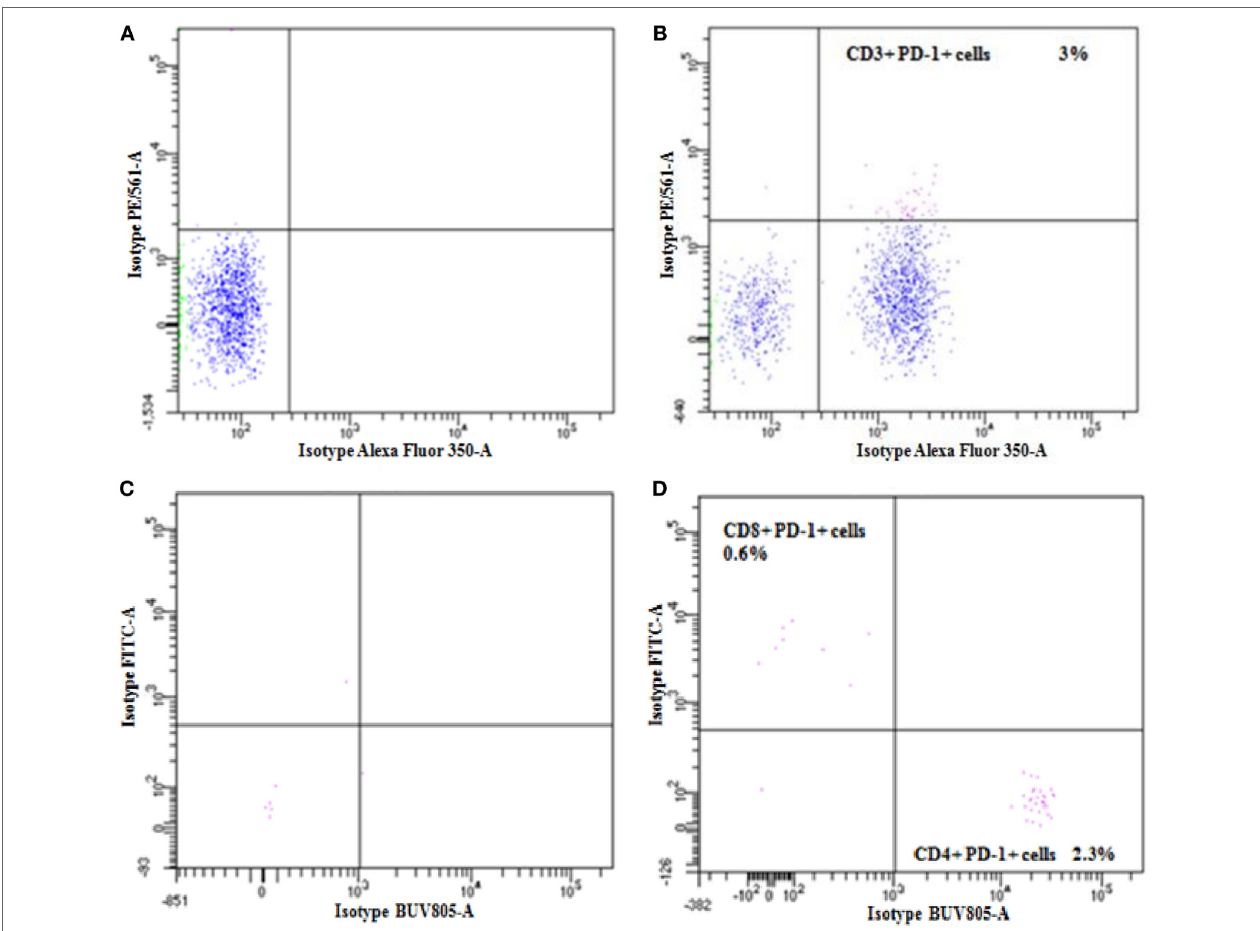
FIgURe 3 | Flow cytometry was used to determine the expression of programmed cell death protein-1 (PD-1) in the patient CD3 + , CD4 + , and CD8 + T cells before nivolumab treatment. Panels (a,B) are dot plots for isotype control and for PD-1 staining in CD3 + , respectively. Isotype control and PD-1 staining in CD4 + and CD8 + cells are represented in panels (C,D) .